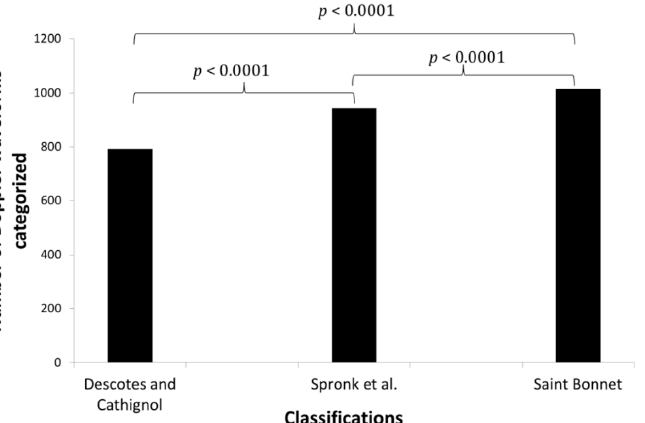
Figure 2. Differences in categorization between the different classifications. Side-by-side comparison of the three classifications categorization rate. p values according to Chi squared test. Aside from type E of the simplified Saint-Bonnet classification, there was at least one waveform in each category of all three classifications (Table 2). Table 2. Categorization details according to the Saint-Bonnet, Spronk et al. and Descotes and Cathignol classifications.